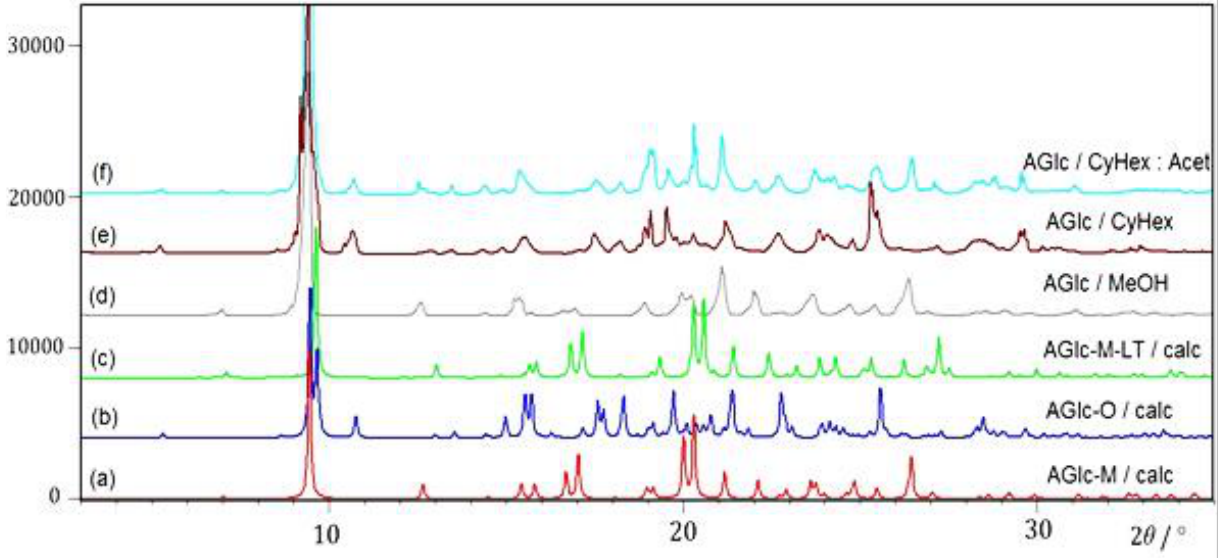
Figure 6. Powder X-ray diffraction patterns of AGlc recrystallised from methanol ( d ), cyclohexane ( e ), and the cyclohexane – acetone (3:1) mixture ( f ). The reference patterns of polymorphic forms AGlc- M , AGlc- O , and AGlc- M - LT (calculated from data from the X-ray structure analysis) are given in red, dark blue, and green, respectively ( a – c ).